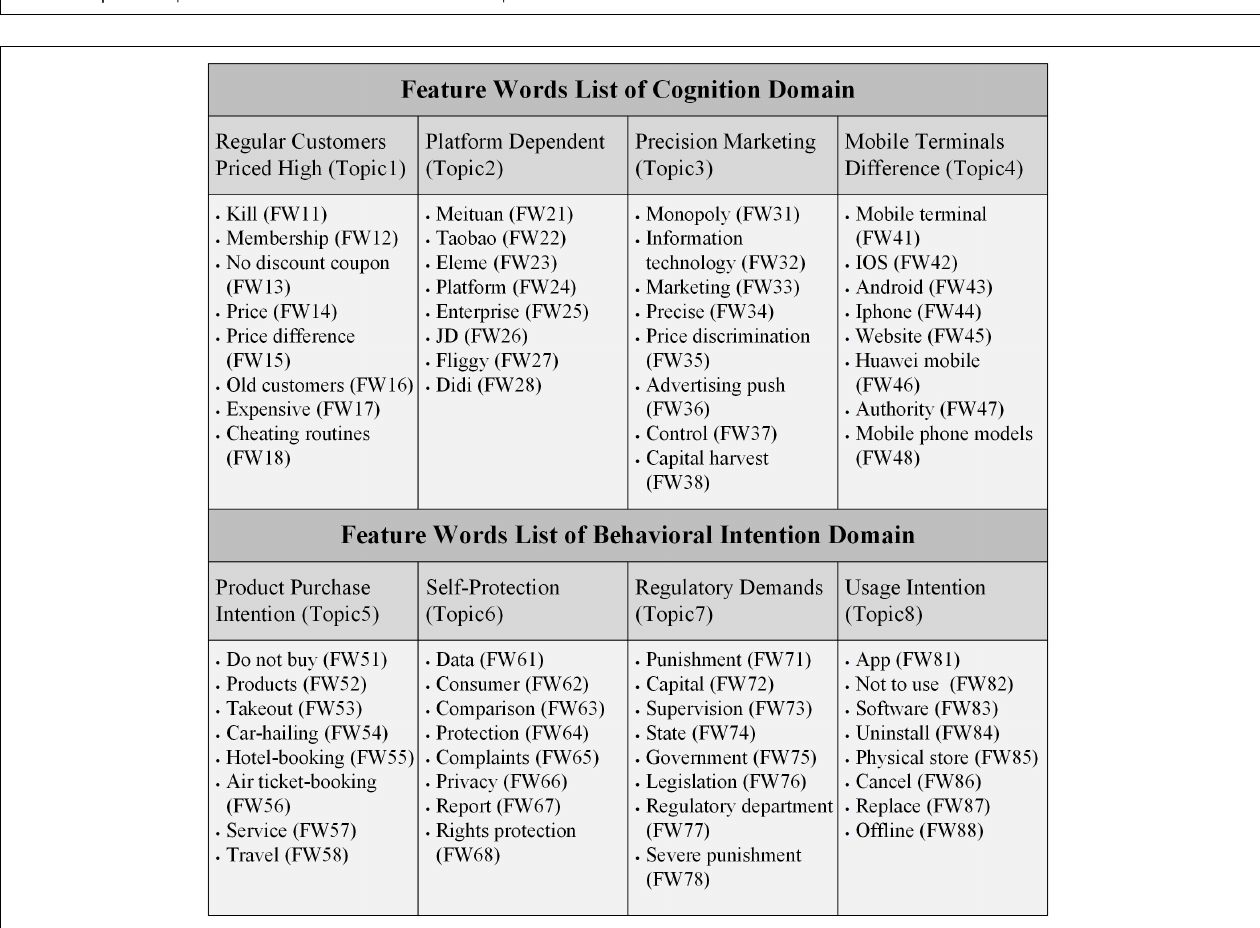
FIGURE 5 | The composition chart of the Labeled LDA model experimental results.